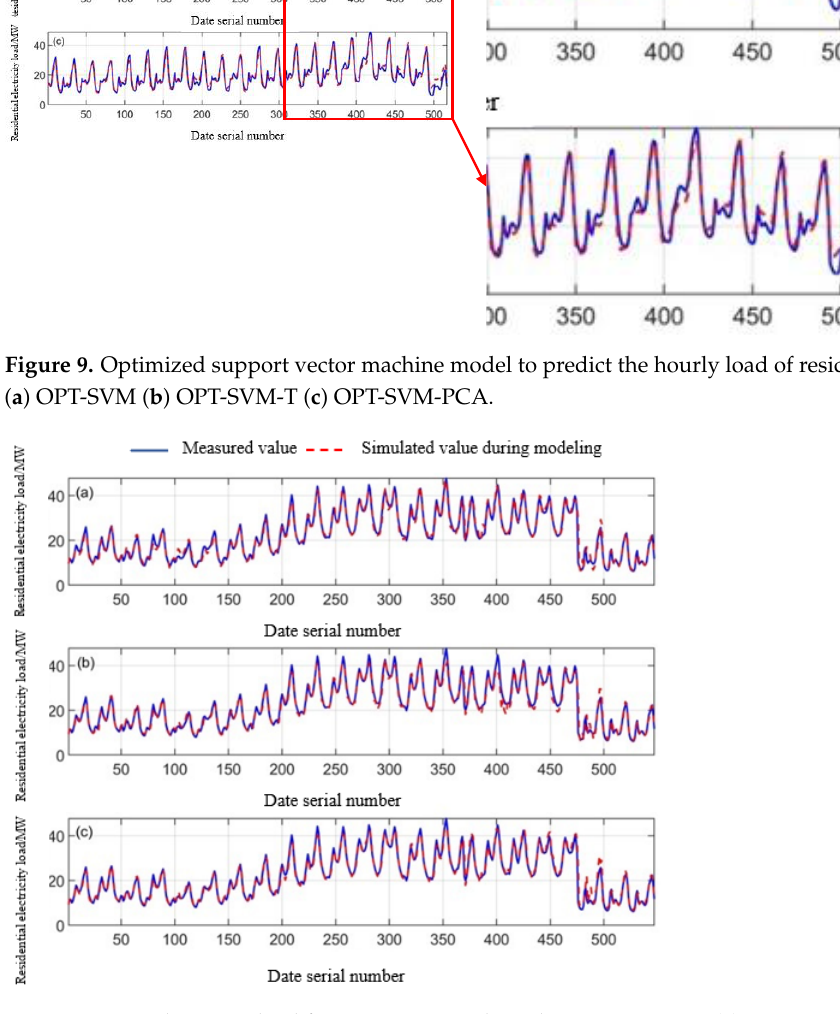
Figure 10. Hourly power load forecasting in residential area in summer: ( a ) OPT-SVM ( b ) OPT-SVM- T ( c )